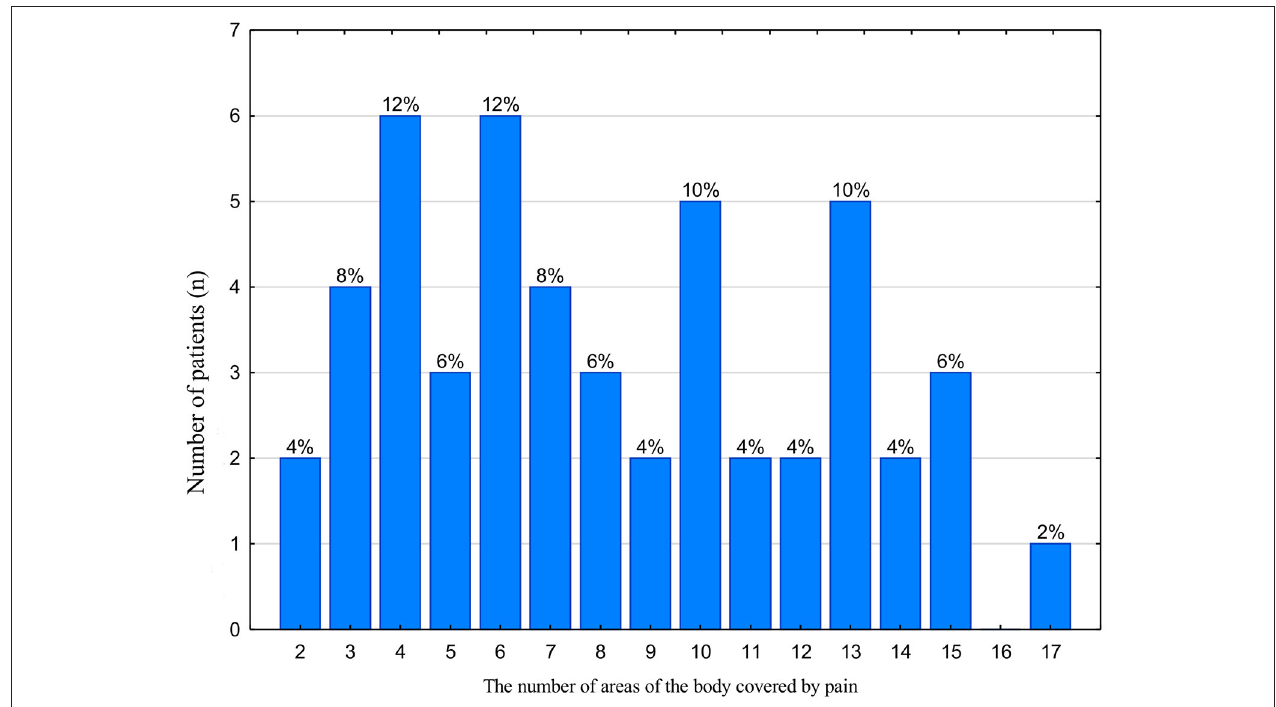
FIGURE 3 | Location of the pain areas in the whole study group ( n = 50). The number of patients and the corresponding percentage in the study group are